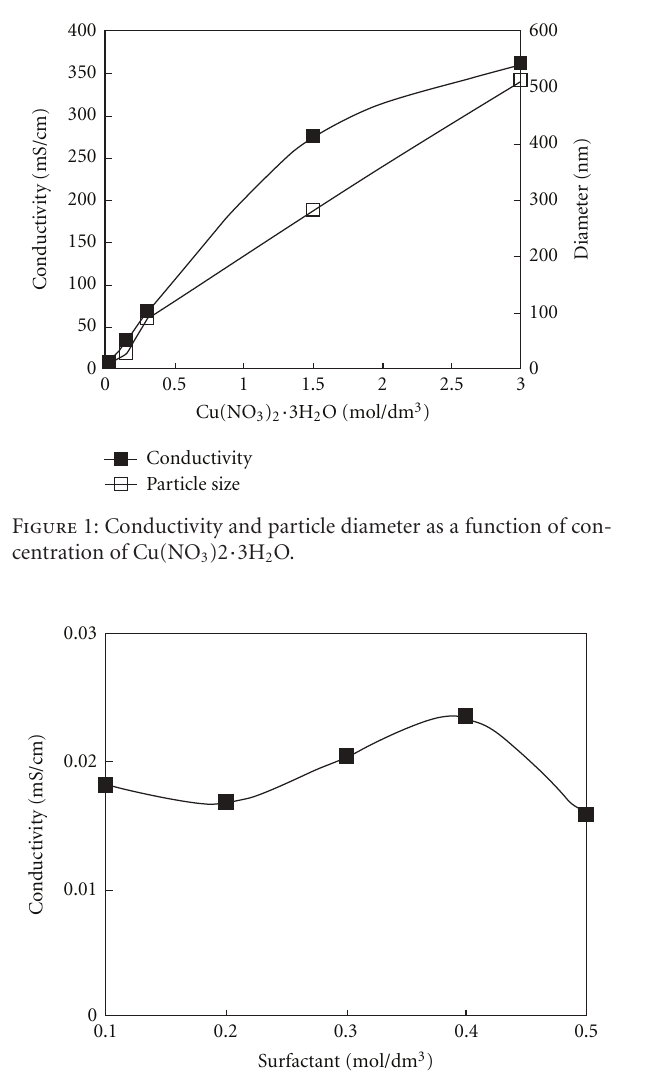
Figure 2: Conductivity as a function of surfactant concentration in the absent of copper ion.